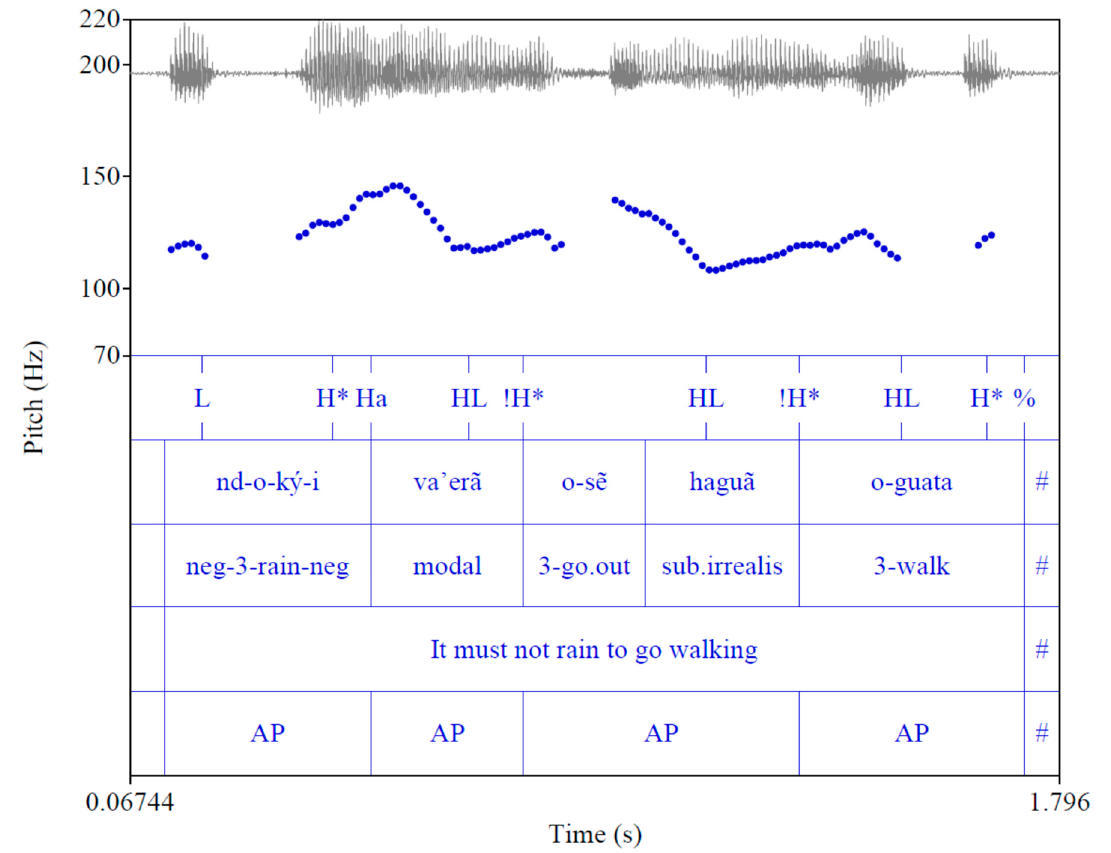
Figure 4. Ndokýi va’erã os ẽ haguã oguata. Figure 4. Ndok ý i va’er ã os ẽ hagu ã